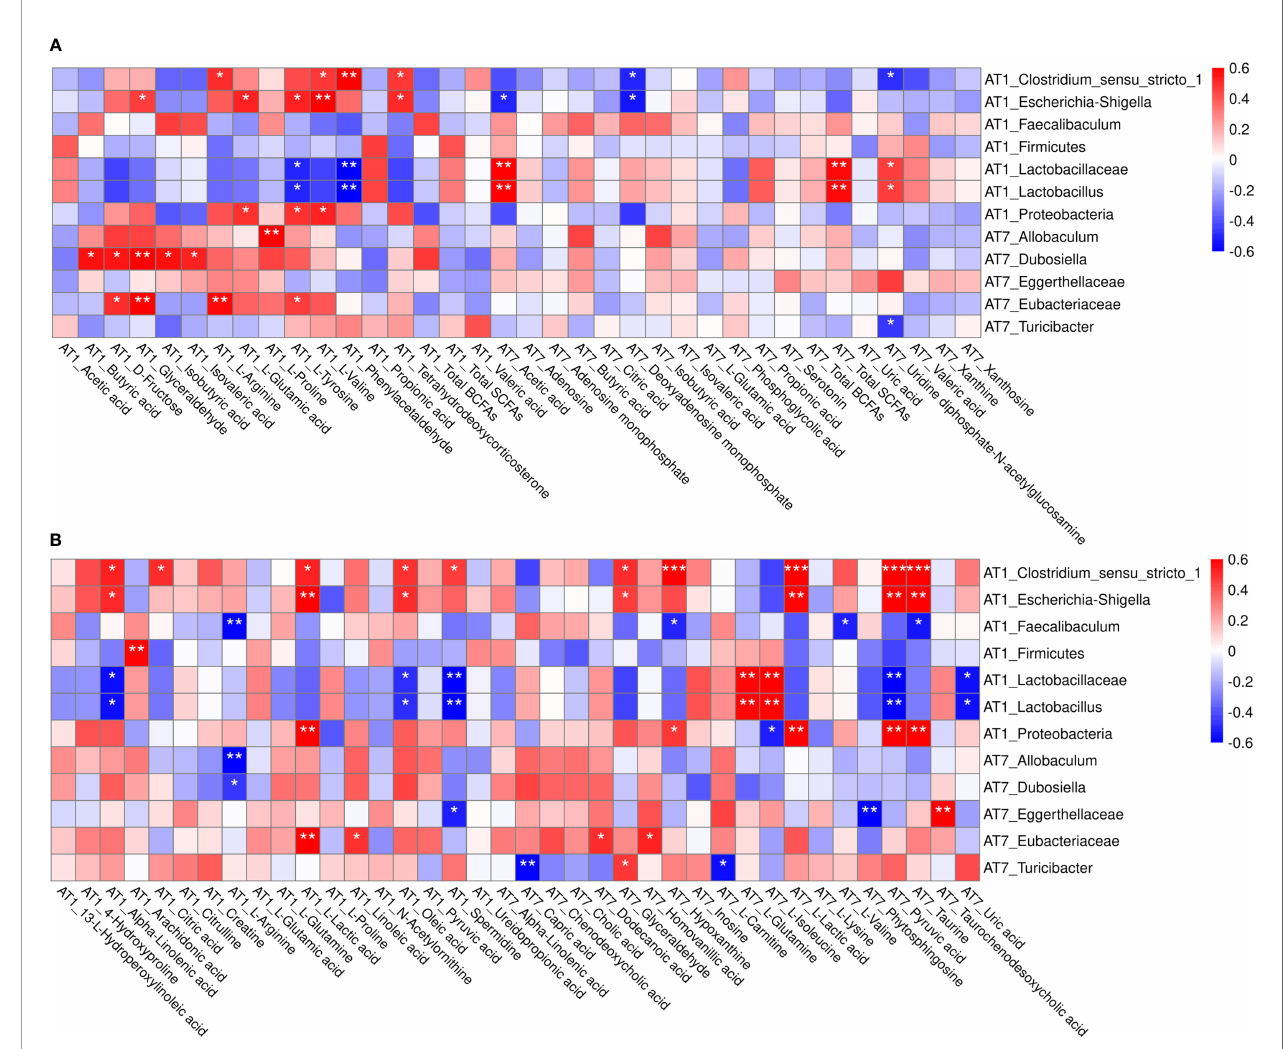
FIGURE 10 | Spearman ’ s correlation analysis between the differential feces metabolites and fecal microbiota (A) , and the differential serum metabolites and fecal microbiota (B) on AT1 and AT7. The symbol (*) indicates a signi fi cant association between metabolite and microbiota (*P < 0.05, **P < 0.01, and ***P < 0.001). Red color indicates a positive correlation, and blue color indicates a negative correlation. AT1, the 1st day after transportation; AT7, the 7th day after